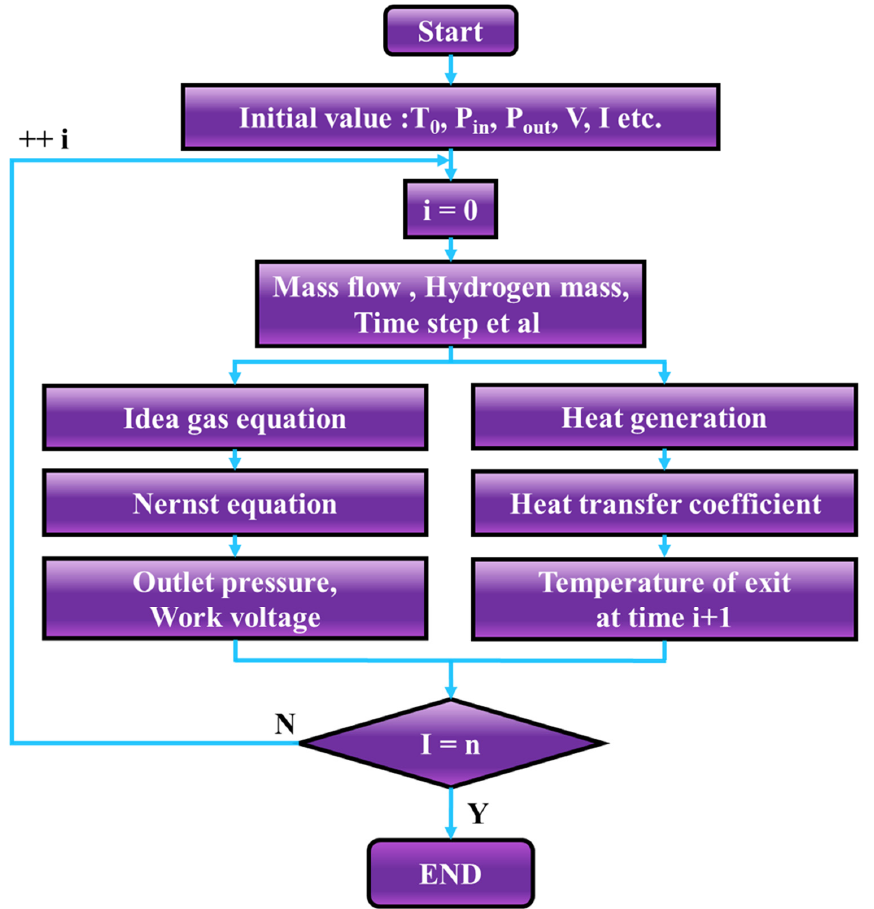
Figure 3. Flow chart of the analytical model.